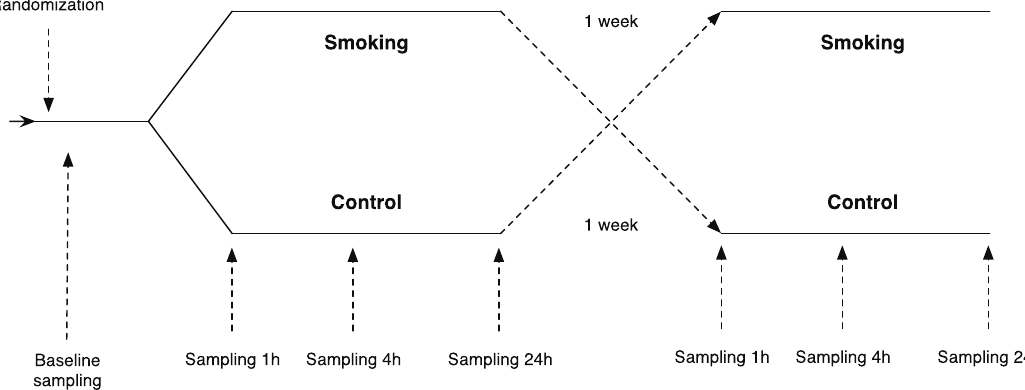
Figure 1. Study design. 12 healthy volunteers were randomized to either smoking or not smoking (control) in a crossover fashion. A time period of at least 1 week separated the experiments. Blood sampling was performed at baseline, 1 h, 4 h and 24 hours.